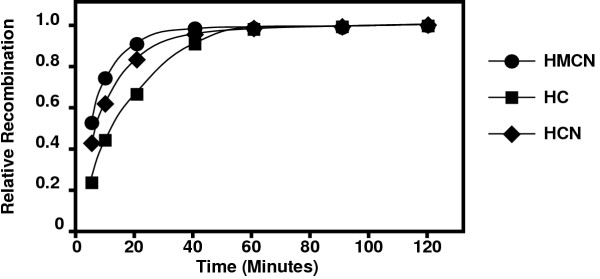
Kinetics of Cre binding and/or uptake. Tex.loxp.EGFP cells were treated with HNC (3 μM), HNCM (10 μM) and HC (5 μM) for different lengths of time; were washed three times with PBS and were analyzed for Cre-mediated recombination as described in Figure 1.